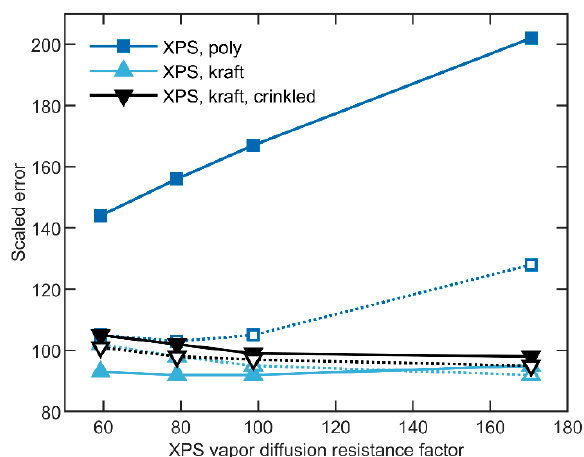
Figure 25. Scaled error for XPS vapor diffusion resistance factor values. Solid symbols represent North wall results, while open symbols South wall results.